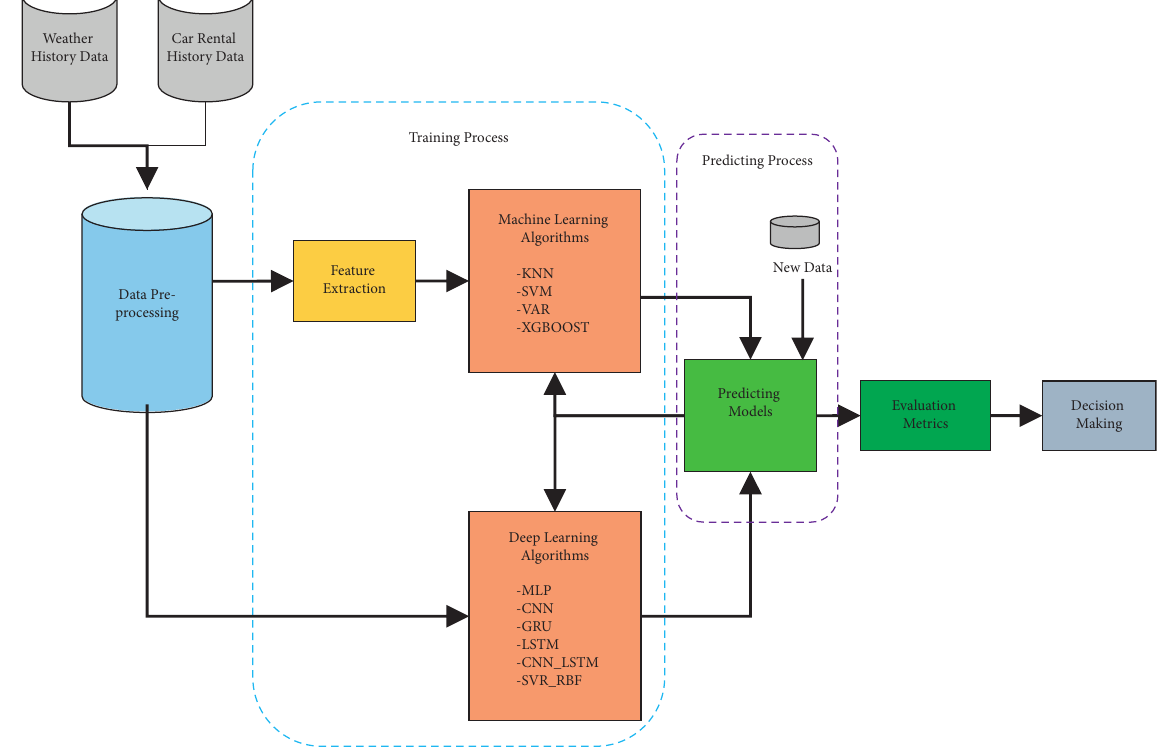
Figure 5: The framework of the proposed